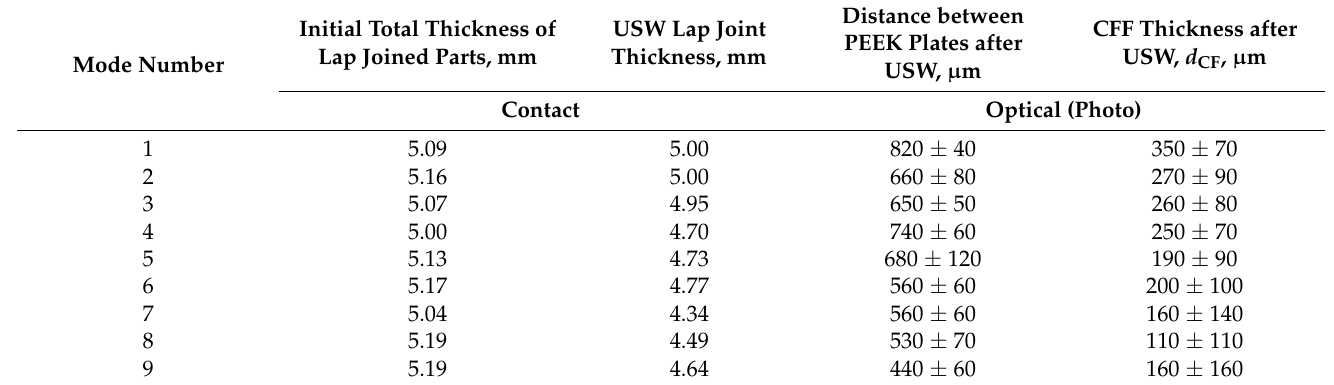
Table 4. The dimensional characteristics of the USW lap